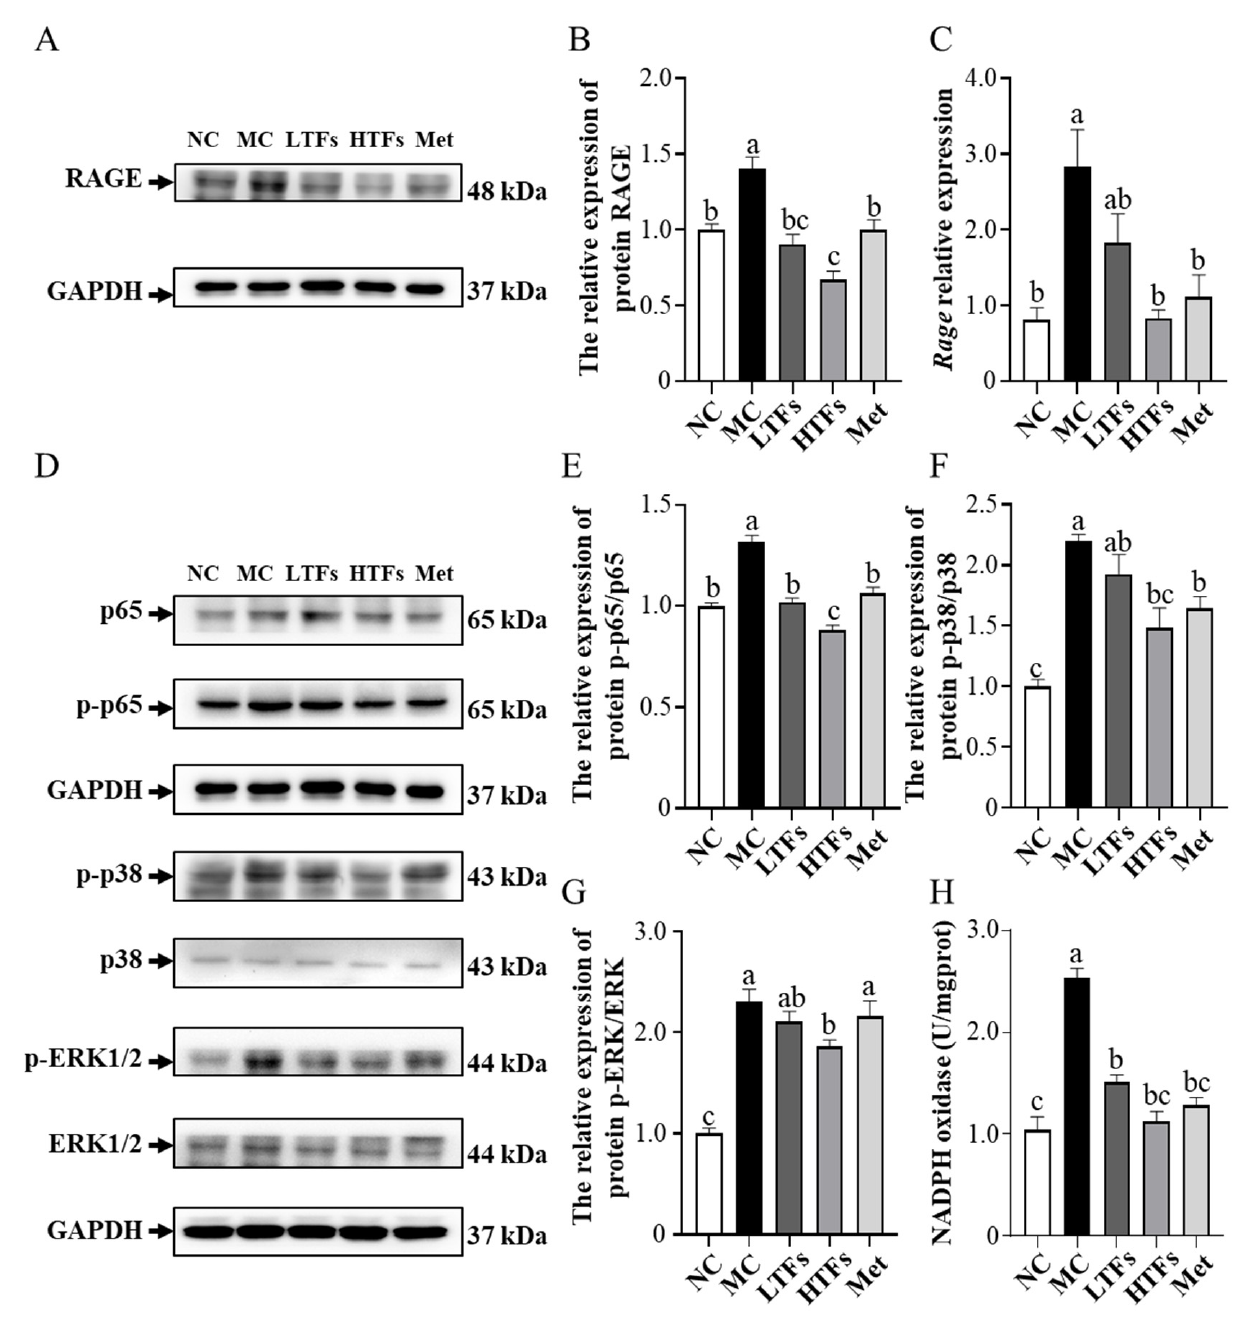
Figure 6. TFs regulate MAPK/NF- κ B signal pathway in the kidney tissues of T2DM mice. ( A ) Western blot analysis of RAGE; ( B ) quantification of RAGE protein expression; ( C ) the mRNA expression of RAGE; ( D ) Western blot analysis of MAPK/NF- κ B signal pathway, including p65 ( E ), p38 ( F ), ERK1/2 ( G ); ( H ) NADPH oxidase activity. NC: normal control; MC: diabetic model control; LTFs: low-dose TFs; HTFs: high-dose TFs; Met: metformin. Each value represents the mean ± SEM ( n = 6). Values with different letters (a–c) differ from each other significantly ( p < 0.05).